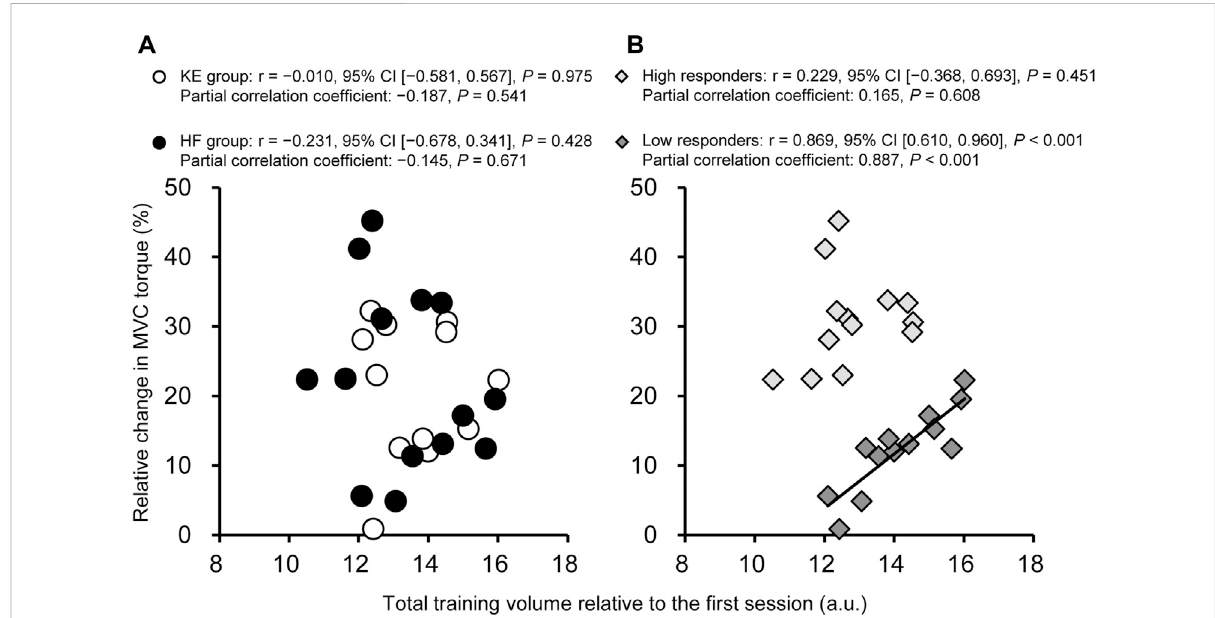
FIGURE 3 The relationships between the total training volume and changes in maximal voluntary contraction (MVC) torque in (A) the knee extension (KE) and hip fl exion (HF) groups and in (B) the high and low responders. Changes in MVC torque were determined based on the KE MVC torque values of the KE group and the HF MVC torque values of the HF group. CI, con fi dence